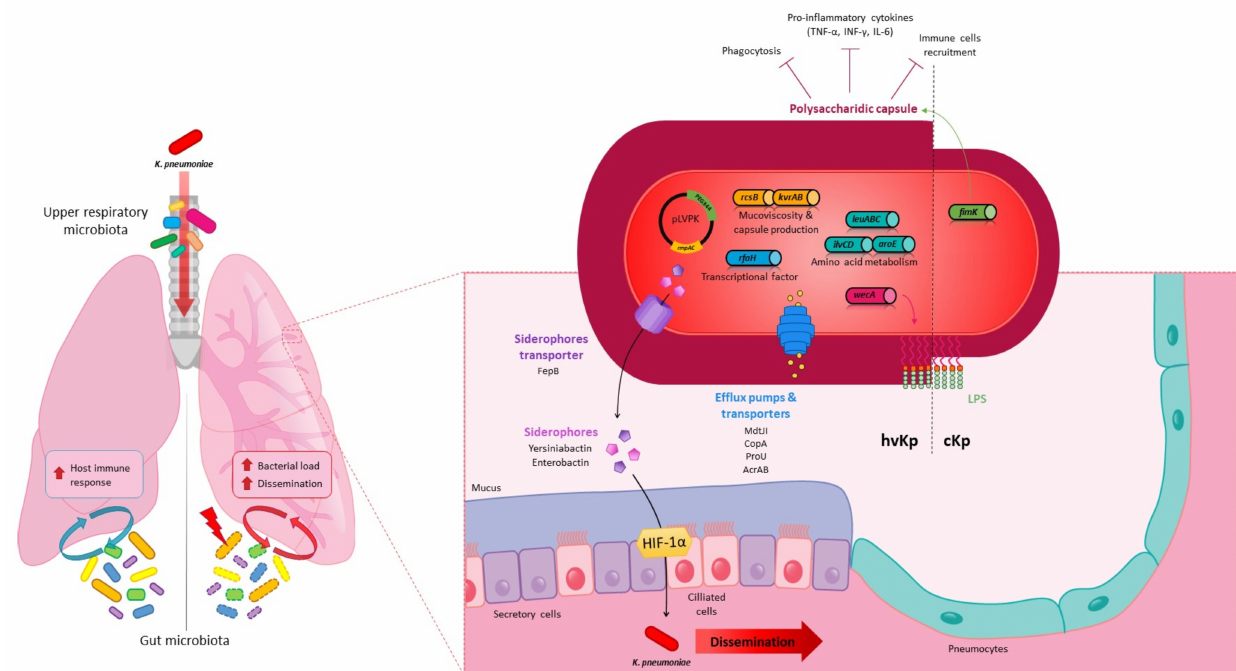
Figure 2. K. pneumoniae in the lungs in an in vivo murine model Local (respiratory) and distal (gut) microbiota (yellow, blue, green, and purple ovals) can modulate the host immune response to K. pneumoniae (red oval) lung infection and K. pneumoniae pathogenicity unlike dysbiotic gut microbiota (yellow, blue, green, and purple ovals, dotted line). Virulence factors involved in lung colonization by classic (cKp, right side) or hypervirulent (hvKp, left side) K. pneumoniae strains: Capsule , overproduced in hvKp and finely regulated by many pathways (FimK, RcsB, KvrA, KvrB, RmpA, RmpC); Lipopolysaccharide (LPS), which depends on the wecA gene for the initiation of biosynthesis; Membrane proteins such as transporters and efflux pumps (MdtJI, CopA, ProU and AcrAB); Siderophores enterobactin (Ent) and yersiniabactin (Ybt) and FepB siderophore transporters are present in cKp, but their role in virulence and dissemination through the lung epithelial barrier via hypoxia inducible factor-1 α (HIF-1 α ) stabilization was only characterized for the hvKp strains; Critical fitness genes involved in the synthesis of essential branched chain and aromatic amino acids ( leuABC , ilvCD and aroE ) and RfaH transcriptional